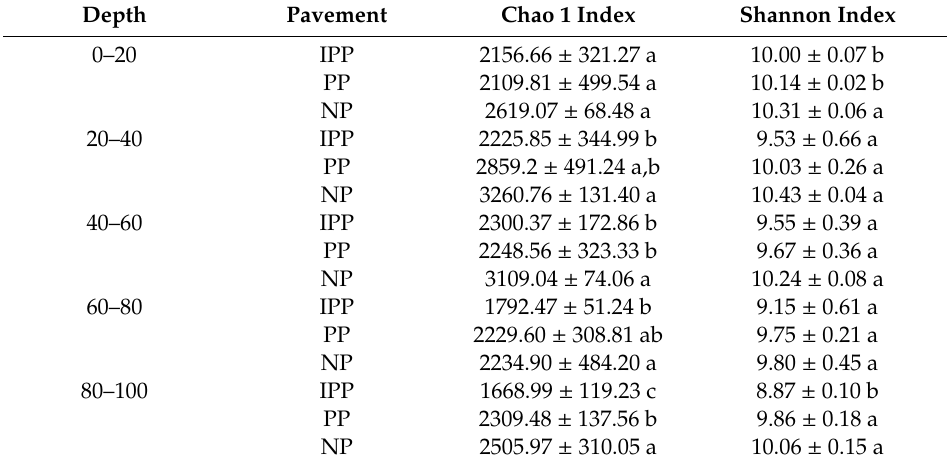
Table 1. The alpha diversity of bacterial communities in di ff erent land pavement. Data are expressed as mean ± standard error (SE), n = 3. Di ff erent letters (a, b and c) indicate statistical significance at p < 0.05 across di ff erent pavements. PP: pervious pavement; IPP: impervious pavement; NP: non-pavement.